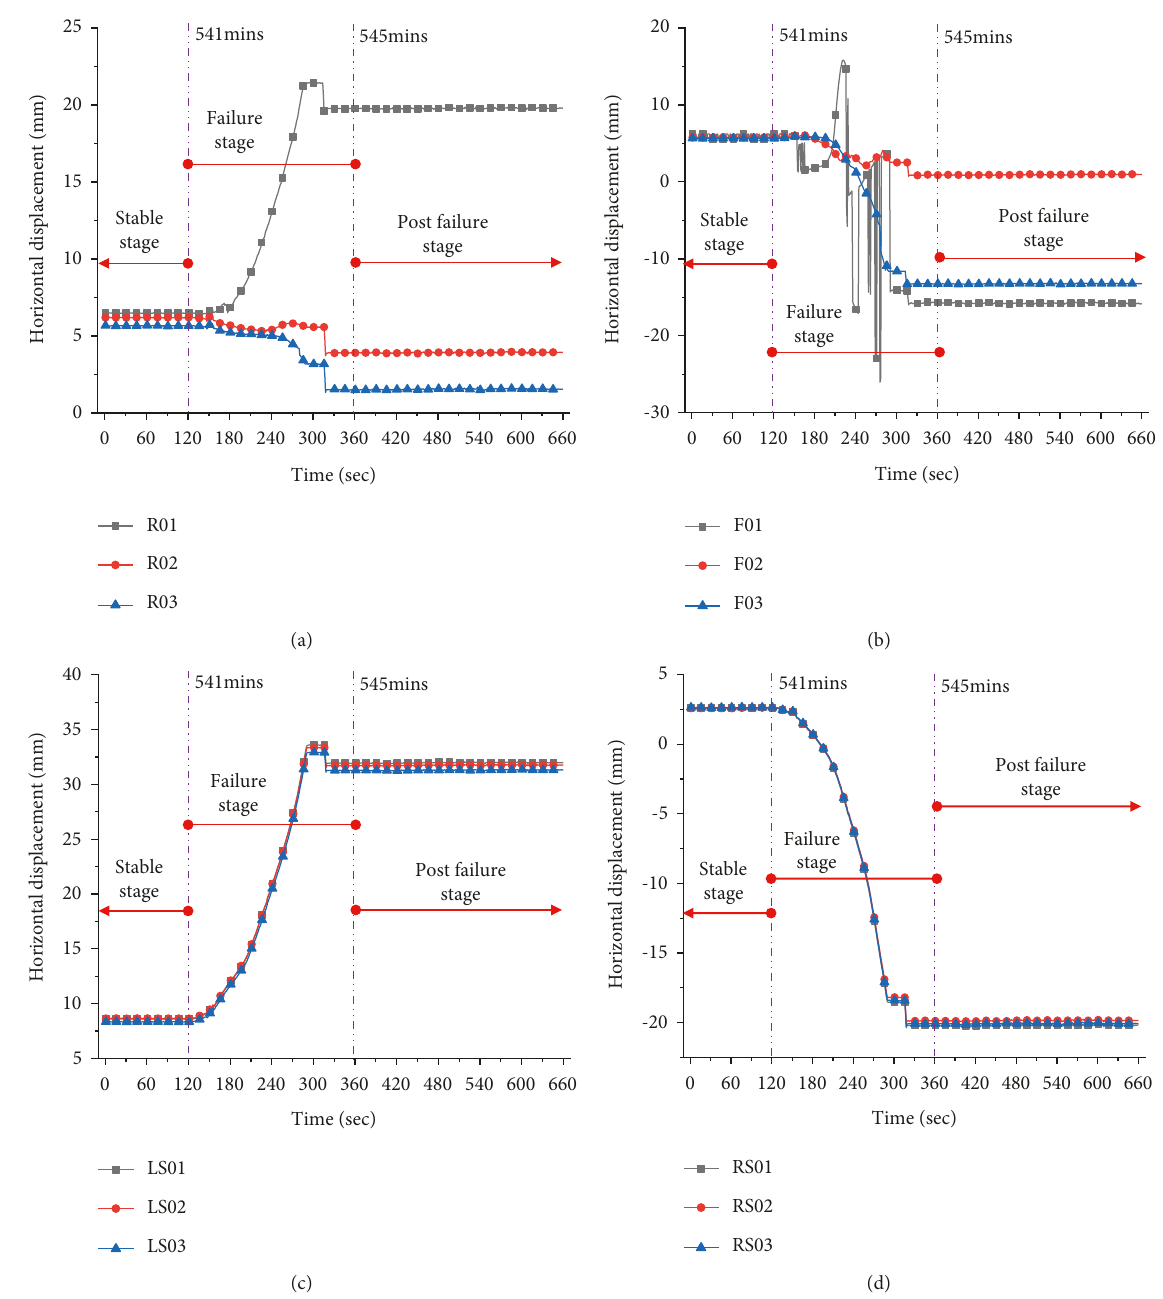
Figure 8: Horizontal displacement of measuring points when the cumulative duration is 539–550 mins; (a) R01, R02, and R03; (b) F01, F02, and F03; (c) LS01, LS02, and LS03; and (d) RS01, RS02, and